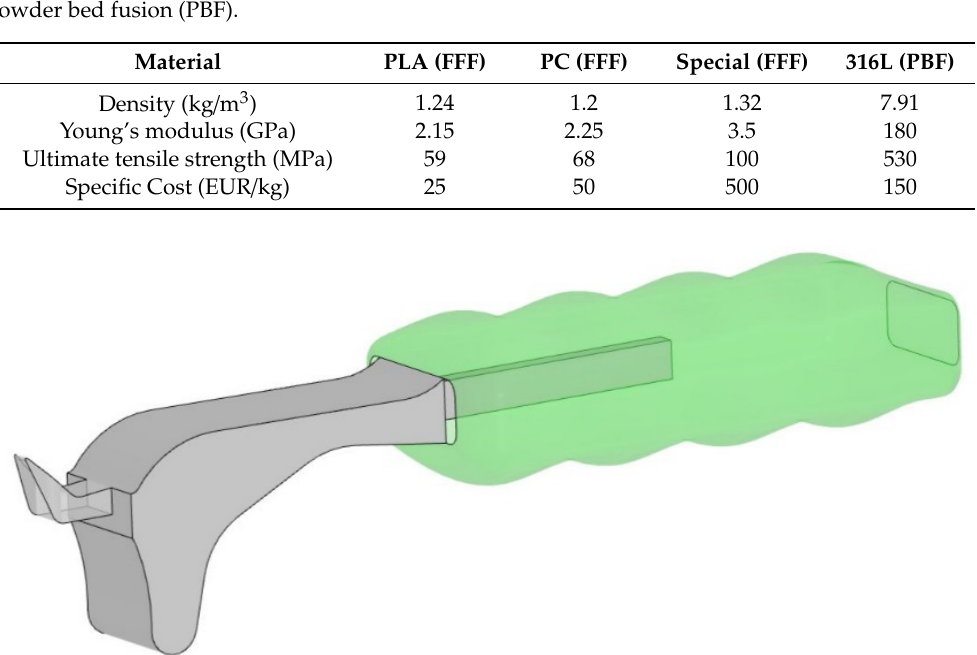
Table 1. Material comparison for additive manufacturing process: fused filament fabrication (FFF) and powder bed fusion (PBF).